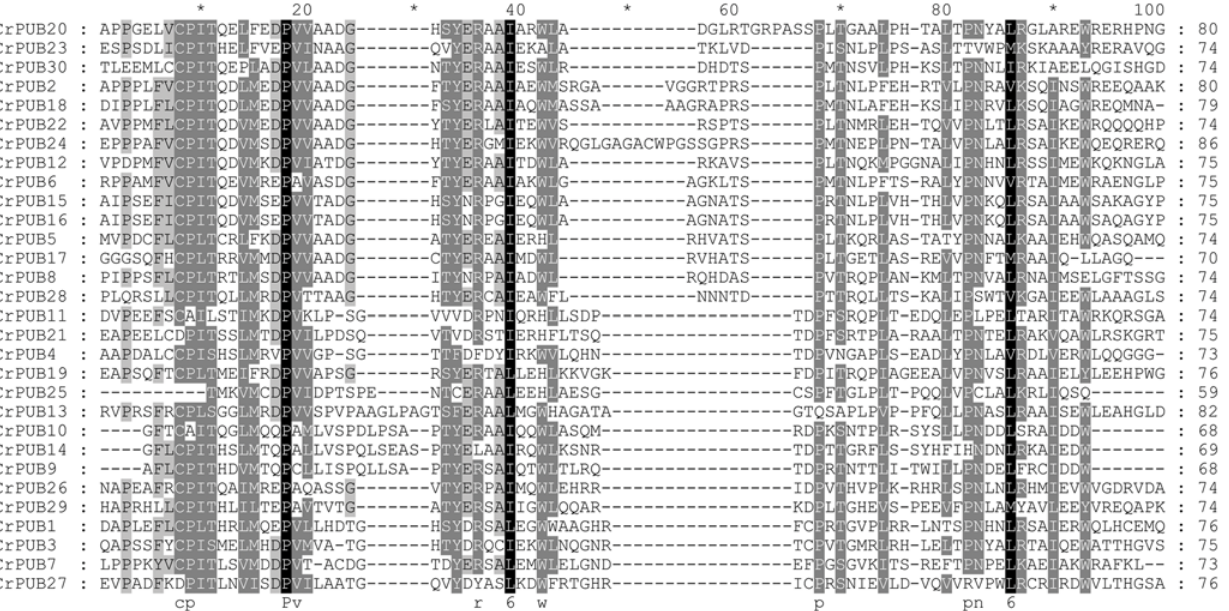
Fig 1. Multiple alignment of U-box domains from CrPUB proteins. The U-box domains in CrPUB proteins were predicted using PROSITE and MEME programs. Their sequences were aligned using ClustalX 2.1, and the alignments were edited using the GeneDoc 2.7 sequence editor. Black, gray and light gray shading indicates the identities and similarities among these sequences as 100%, 80%, and 60%, respectively.